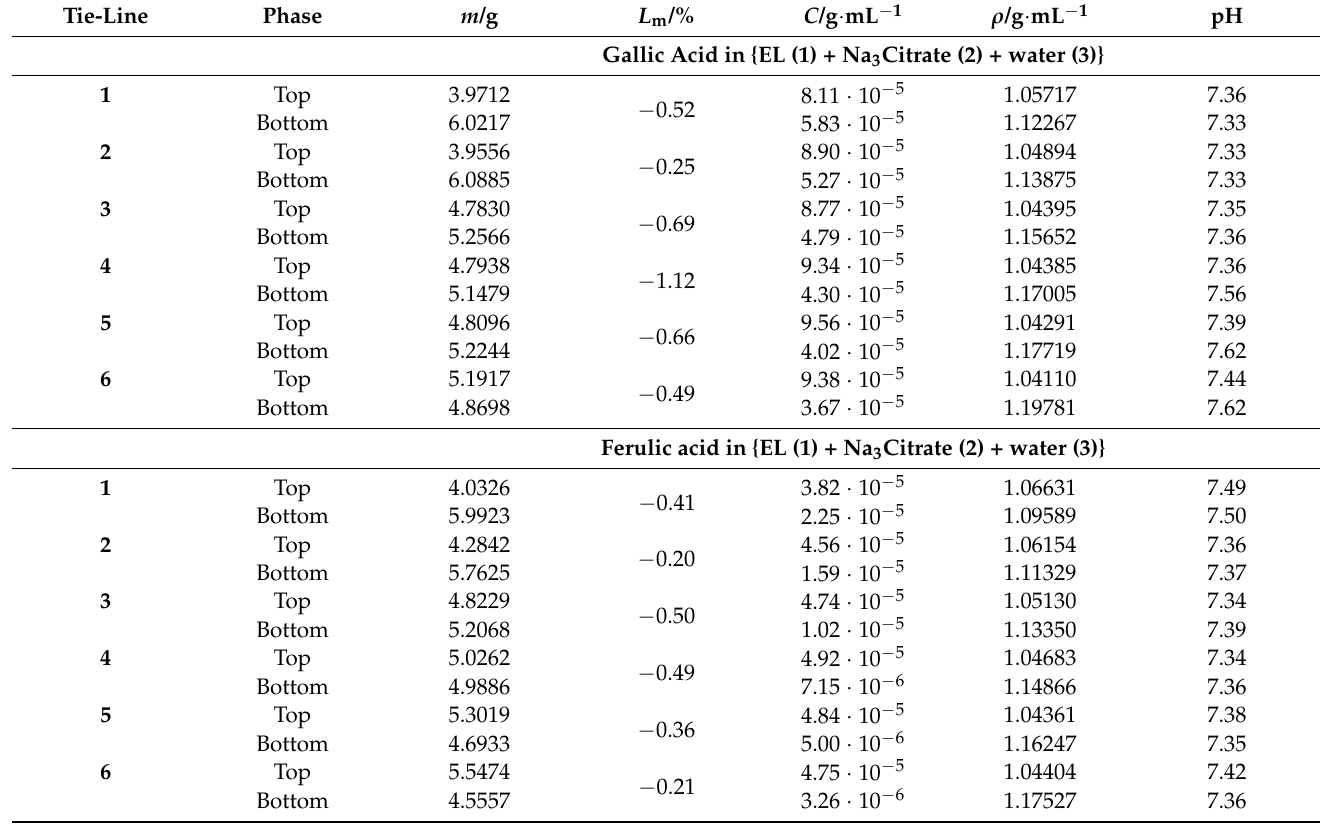
Table 4. Experimental phase mass ( m ), biomolecule mass losses ( L m ), biomolecule concentration ( C ), phase density ( ρ ) and phase pH for the top and bottom phases in the extraction of gallic acid or ferulic acid in the ATPS {ethyl lactate (1) + trisodium citrate or tripotassium citrate (2) + water (3)} at 298.15 K and 0.1 MPa a